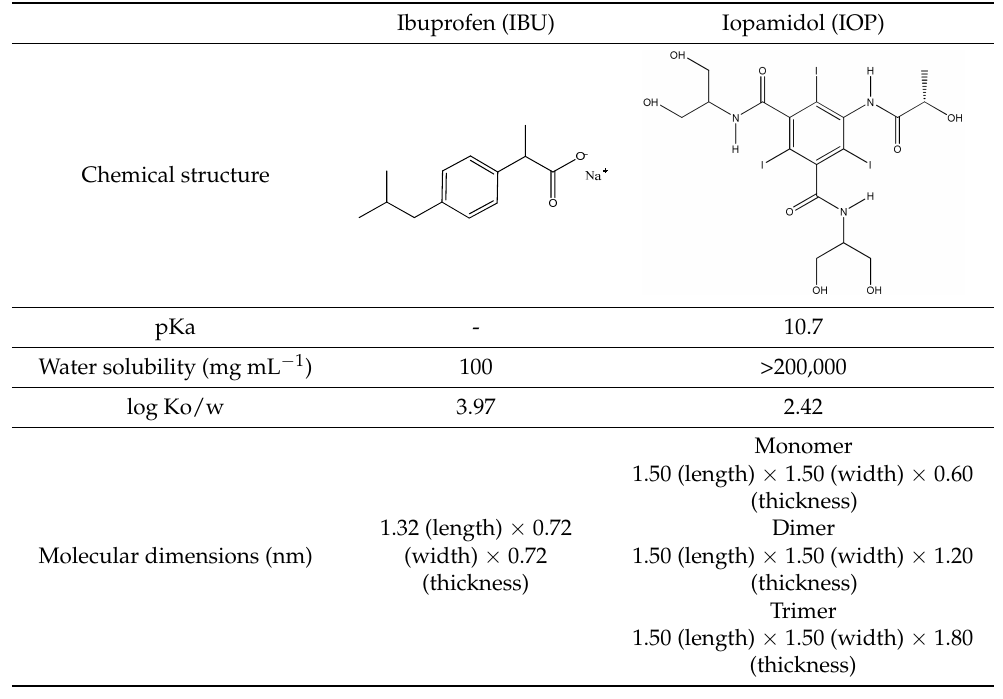
Table 3. Physico-chemical properties of ibuprofen and iopamidol (adapted from ref. [23] with permission of the Royal Society of Chemistry).